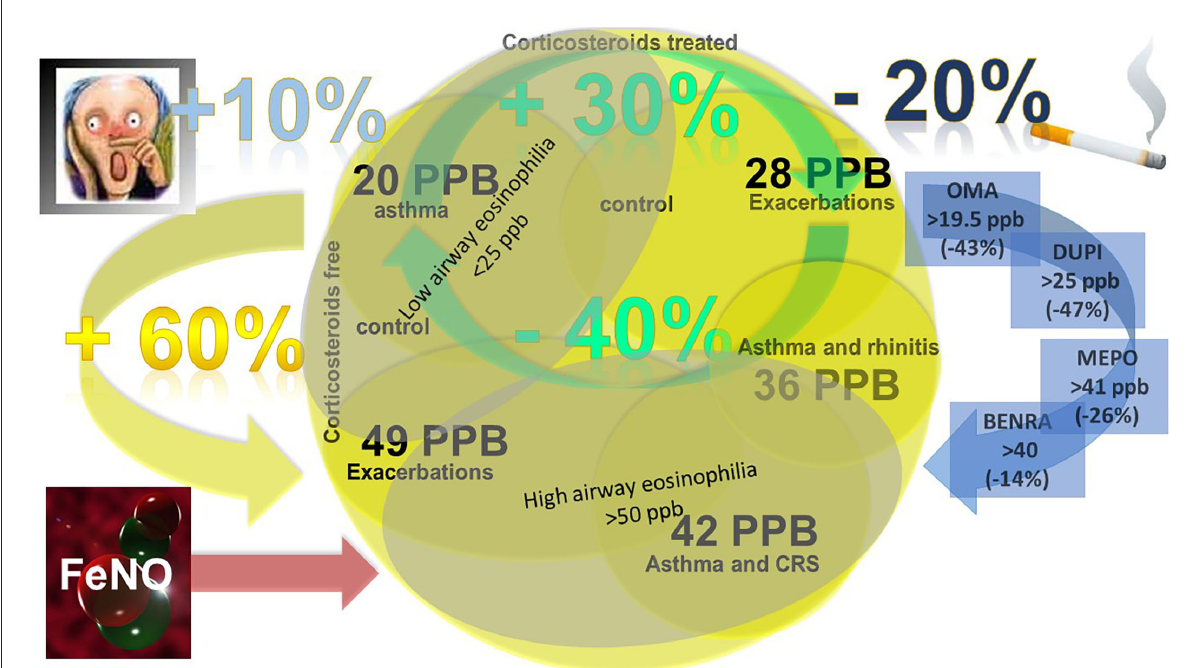
FIGURE1 FENO cut-off levels in asthma clinical practice. FENO > 20 ppb for asthma diagnosis (88% sensitivity and 79% specificity); FENO > 36 and > 42 ppb for asthma diagnosis and concomitant rhinitis and CRS, respectively; FENO < 25 ppb less likely for airway eosinophilia; FENO > 50 ppb more likely for airway eosinophilia and ICS responsiveness; FENO > 28 ppb and > 49 ppb predicts exacerbations in steroid-treated and naïve patients, respectively; FENO increase + 60% predicts loss of control after steroid withdrawal; FENO increase + 30% predicts loss of control in steroid-treated patients; FENO decrease − 40% predicts good control in steroid-treated patients; when assessing asthma control/exacerbation smoking habit reduce the quote of FENO of − 20%, rhinitis increase of + 10%; the FENO values predictors of best response to biologics and the FENO reduction expected (%) are reported (OMA, omalizumab; DUPI, dupilumab; MEPO, mepolizumab; BENRA, benralizumab).